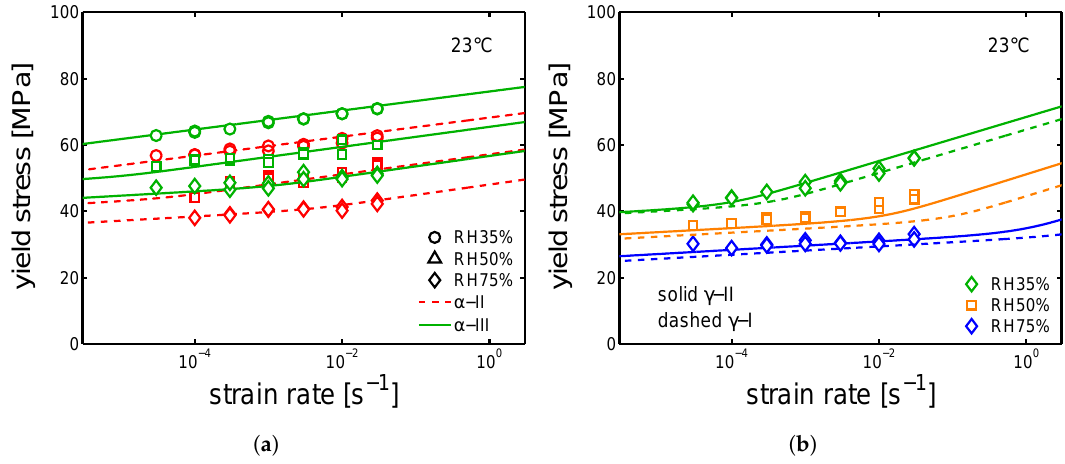
Figure 17. ( a ) yield stress as a function of strain rate for samples conditioned at different relative humidity, ( a ) α -II, α -III and ( b ) γ -II. Testing temperature set at 23 °C.